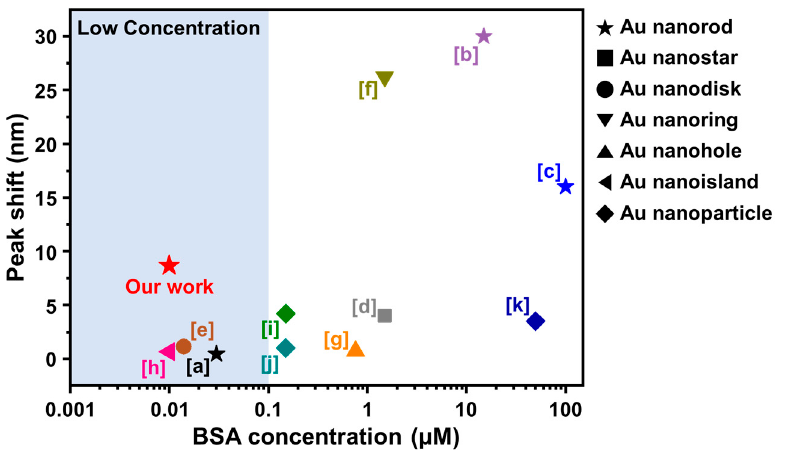
Figure 5. Comparison of nanoplasmonic biosensing performance of the AuNR platform in this study compared to other gold nanostructures reported in the literature. The data correspond to the reported LSPR Δ λ max shifts for BSA protein adsorption at different bulk protein concentrations. The literature results were obtained from the following references: a-[69], b-[70], c-[45], d-[71], e-[72], f-[73], g-[74], h-[9], i-[75], j-[76], and k-[77].